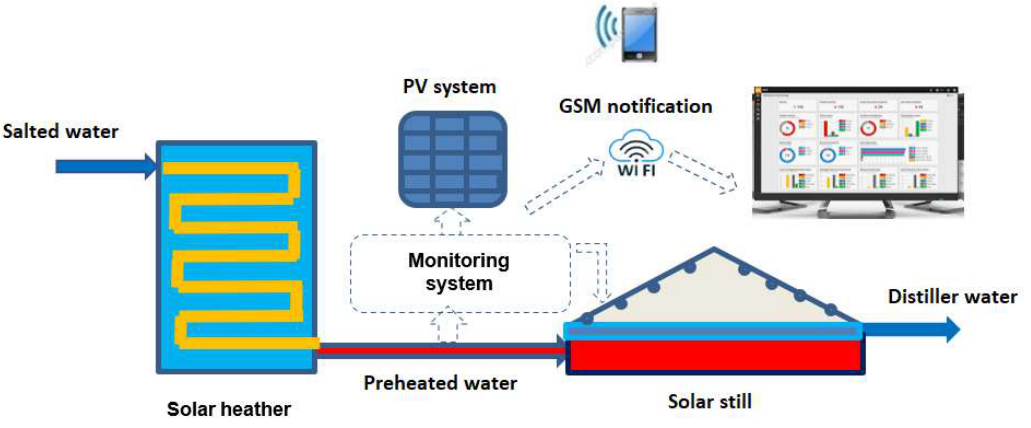
Figure 1. Smart hybrid solar heater–solar still desalination system.